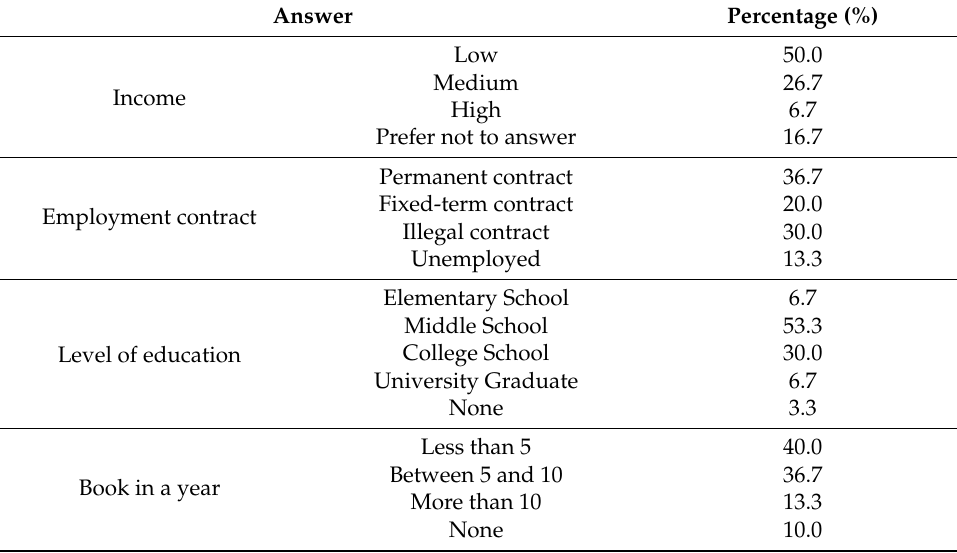
Table 3. Set of responses from the preliminary investigation that focused on income and